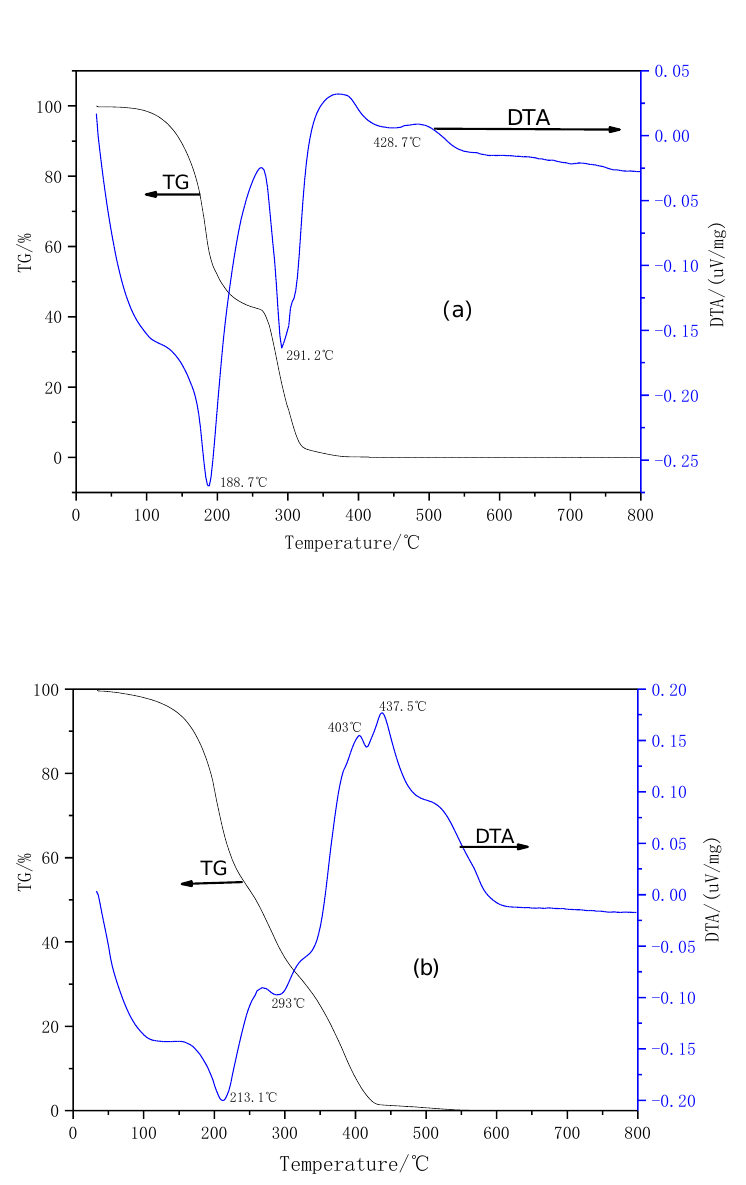
Figure 7. DTA/TG analysis of cover oil ( a ) and varnish ( b ).